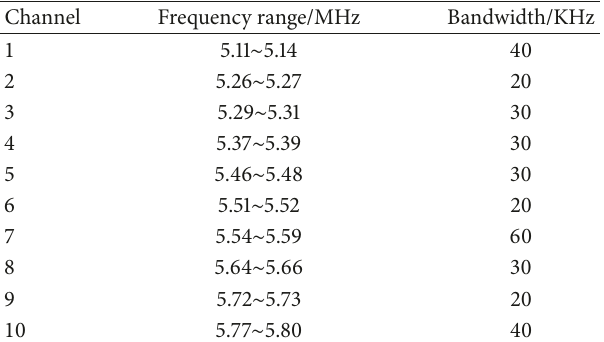
Table 1: Canada 1999 summer available spectrum